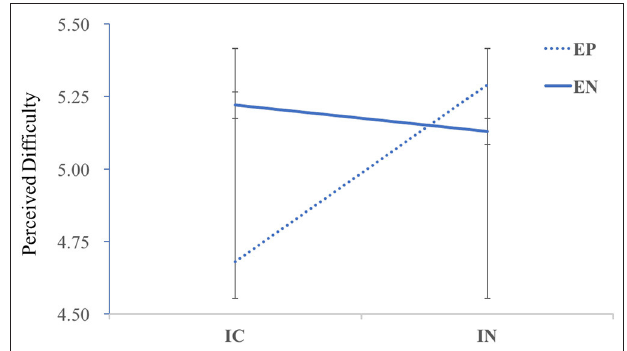
FIGURE 5 | Perceived difficulty by condition in the formal experiment.